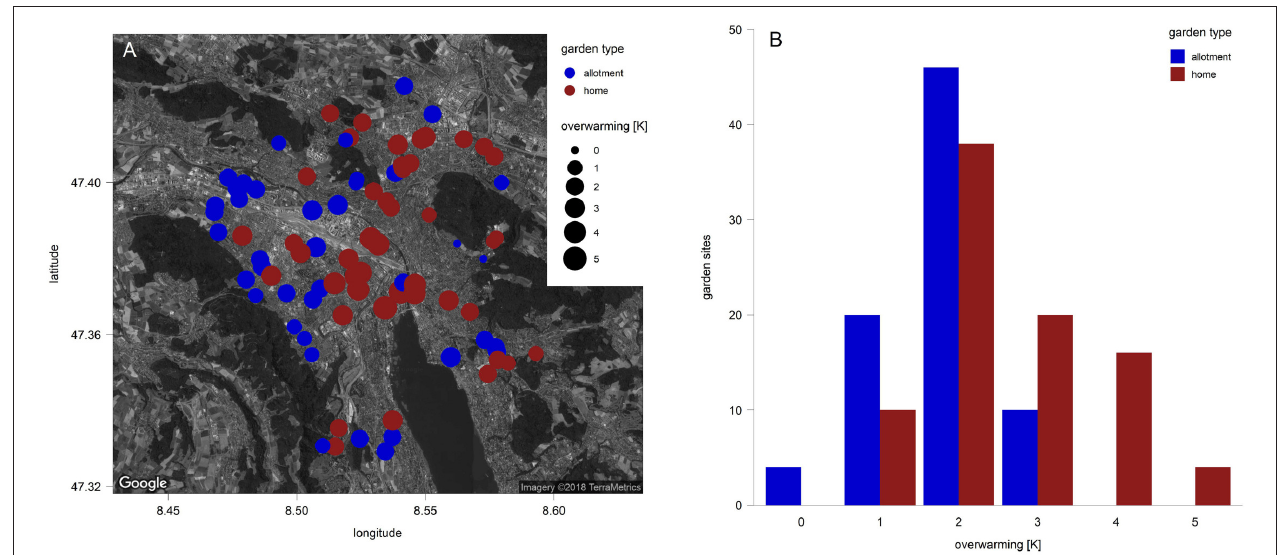
FIGURE 1 | (A) Urban gardens analyzed in the city of Zurich (85 urban gardens with two sampling sites per garden). Colors correspond to the garden types (blue: allotment, red: home) and the point size to the urbanization density gradient, which is represented by a regional climate model with local deviation of mean night temperatures near surface from 0 to + 6 K ( Parlow et al., 2010). (B) Values of local mean night temperature deviations (overwarming), representing the urbanization density gradient in this study.